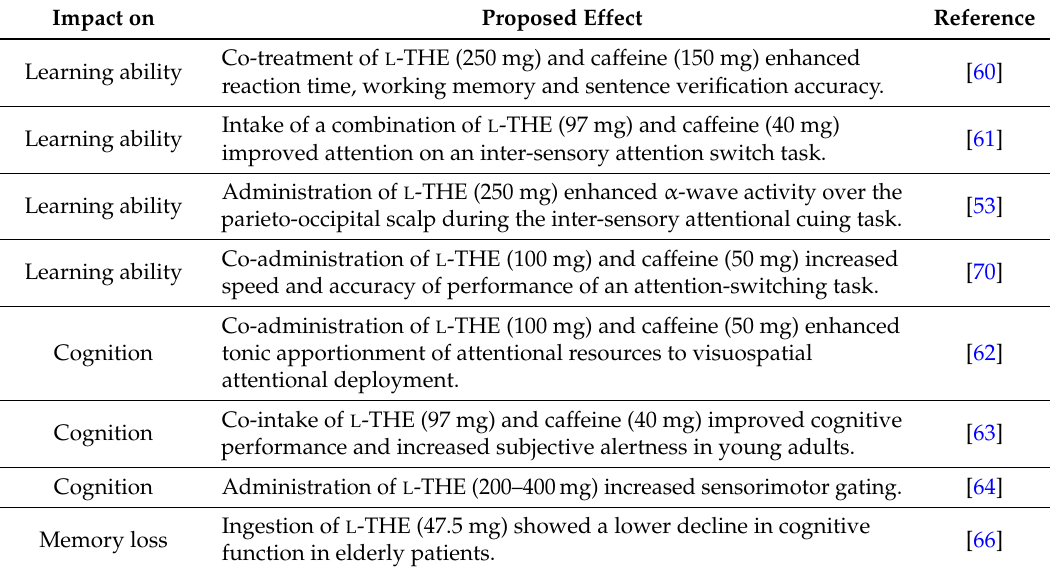
Table 2. The effect of L -THE consumption on learning and